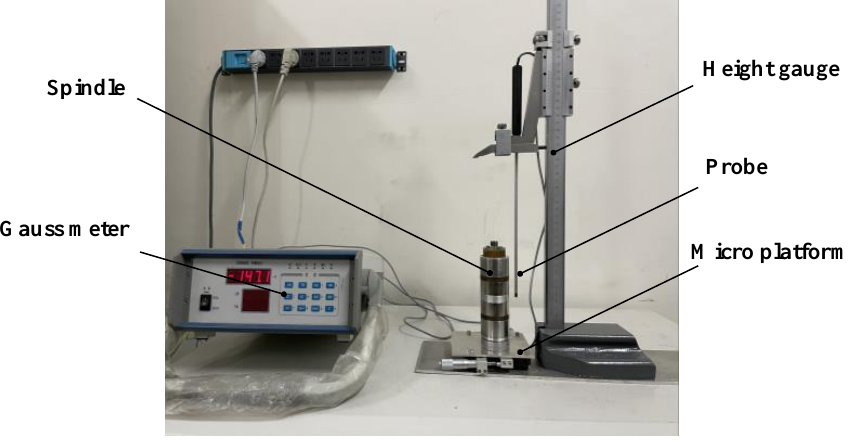
Figure 8. Test platform of magnetic induction strength.